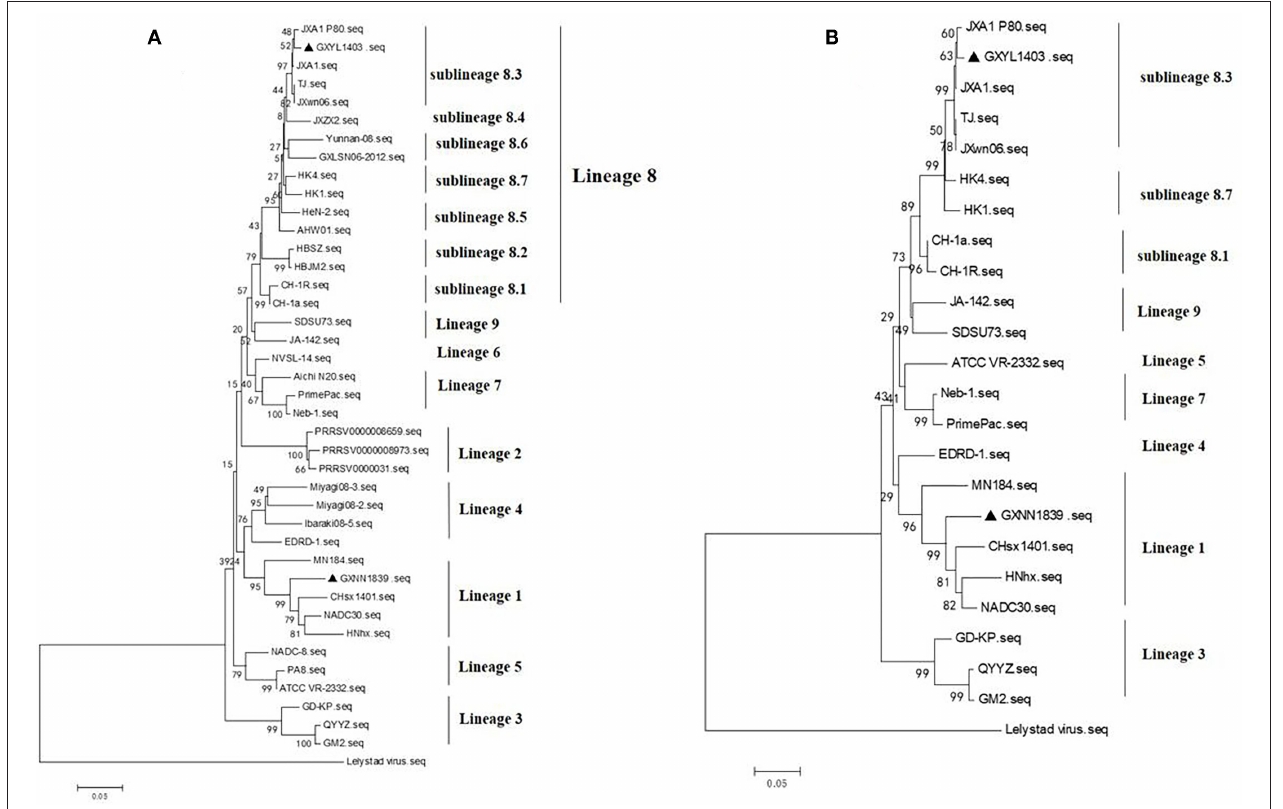
FIGURE 2 | (A) Phylogenetic tree based on ORF5 sequences of isolates from this study and reference ORF5 sequences from PRRSV strains originating from China and other countries. The phylogenetic tree was constructed using the neighbor-joining algorithm based on the p -distance model. The PRRSV ORF5 sequences collected in this study are marked with black triangles. (B) Phylogenetic tree based on full-length genomic sequences of isolates. The GXYL1403 and GXNN1839 in this study and PRRSV reference strains are available in GenBank. The strains isolated in this study are labeled with black